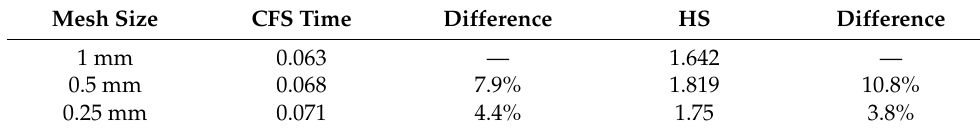
Table 5. Sensitivity analysis of Critical Fraction Solid (CFS) time and Hot Spot (HS). Mesh Size CFS